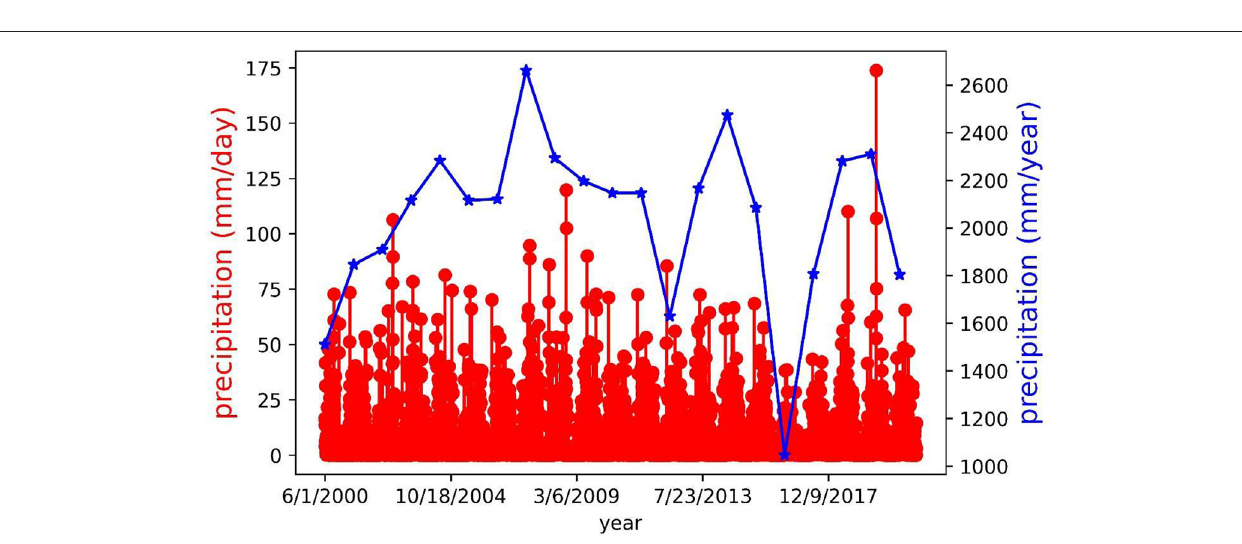
FIGURE 4 | Variation in daily precipitation from GPM IMERG over Pookode Lake over a period of 20 years from 2000 to 2020 along with variation in annual